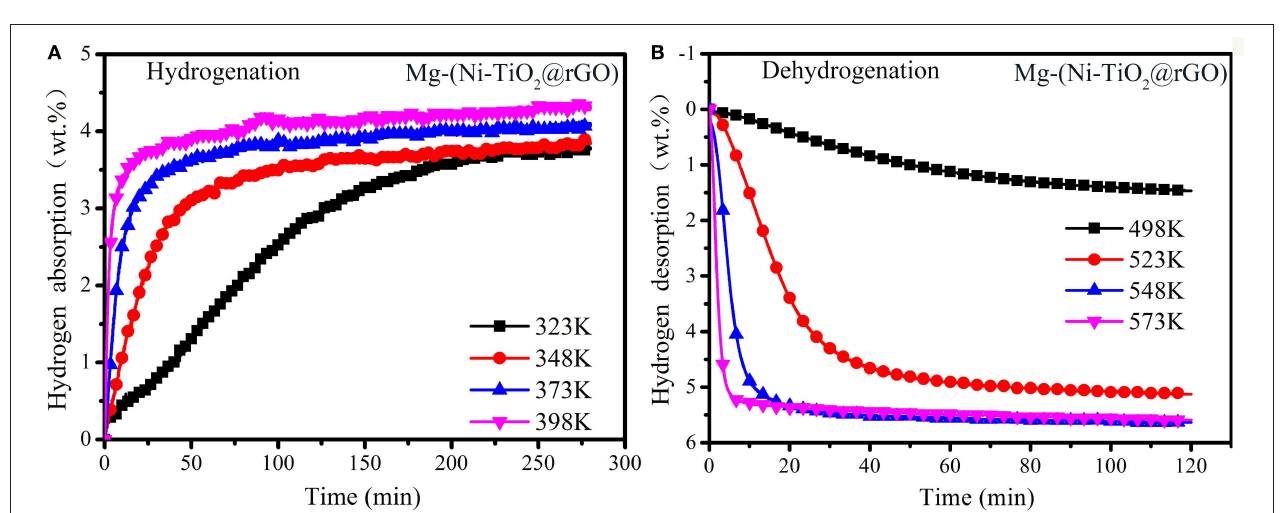
FIGURE 7 | Hydrogenation/dehydrogenation curves of Mg-(Ni-TiO 2 )@rGO composite at different temperatures. (A) Hydrogenation (B) Dehydrogenation.